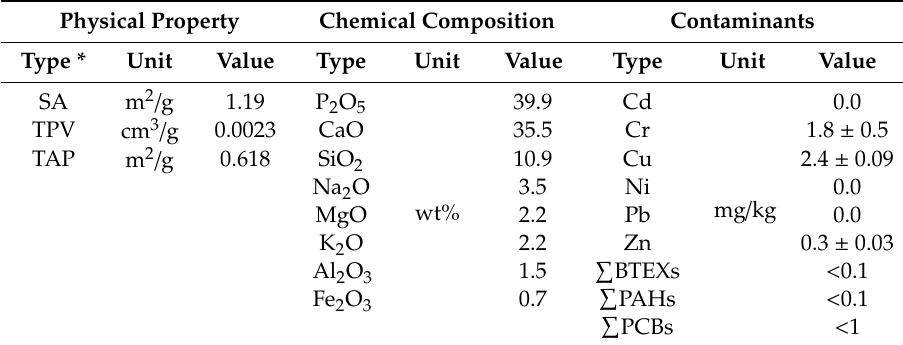
Table 1. Physicochemical characteristics of ash from gasification of poultry feathers. Physical Property Chemical Composition Contaminants Type *